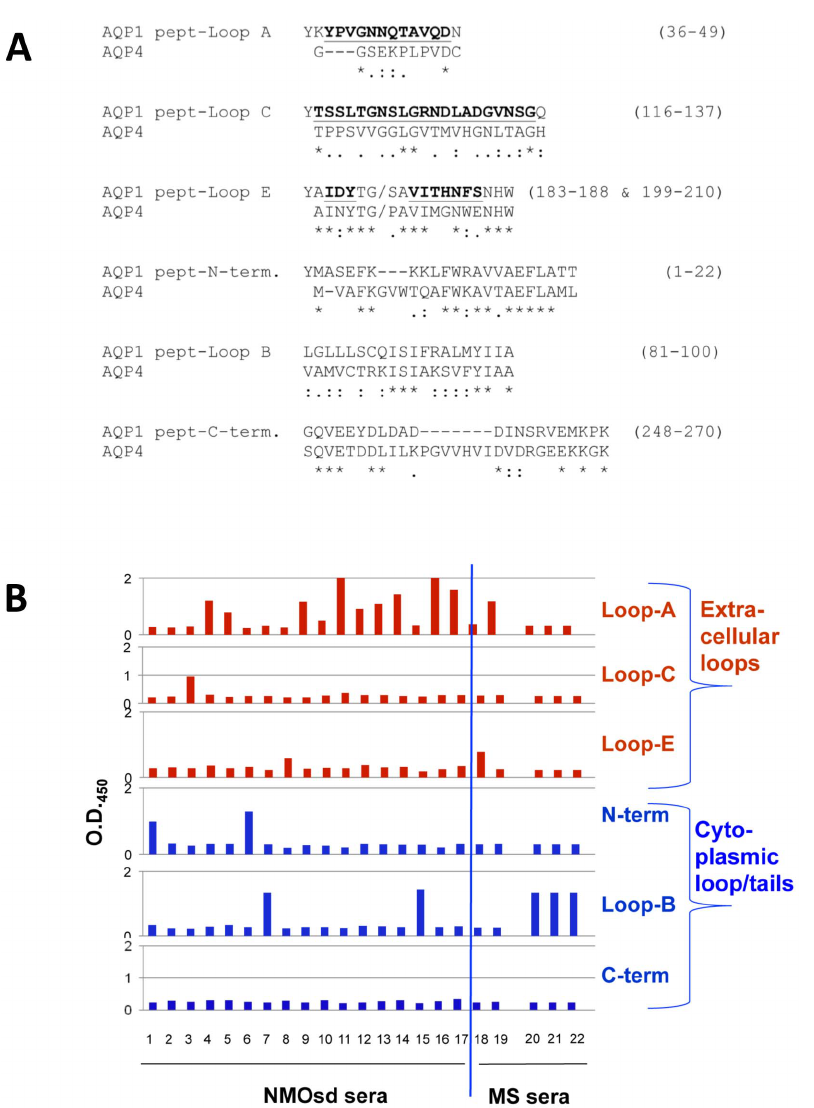
Figure 9. Anti-AQP1 antibody binding to synthetic peptides corresponding to AQP1 extracellular and cytoplasmic domains. A . Synthetic peptides corresponding to human AQP1 extracellular loops A (residues 36–49), C (116–137), and E (183–188, 199–210) or to the intracellular N-terminus (1–22), loop B (81–100), and the C-terminus (248–270) are shown (from Uniprot/Swissprot entry P29972, for the human AQP1). Extracellular residues are shown in bold and underlined. Loop-E is formed by two segments separated by a 14 residue gap; in ‘‘pept-Loop-E’’, 10 of these 14 residues (between TG and SE) were omitted (marked by:..). In the first 4 peptides, an extra tyrosine residue was added to the N-terminus for future radioiodination studies. Below the AQP1 peptide sequences are shown the corresponding AQP4 sequences; (*), identical amino acid residues; (:) and (.), homologous residues. B. Peptide mapping with anti-AQP1 positive sera . 22 sera from patients with known clinical characteristics (17 NMOsd and 5 MS) were tested for binding to 6 synthetic peptides corresponding to the 3 extracellular loops (loops A, C and E) and to the 3 cytoplasmic segments (N-terminal, Loop-B and C-terminal) by an ELISA assay. Positive values are considered those above O.D. 450 0.45 (see Methods). It is shown that most NMOsd sera bind to the Loop-A peptide.